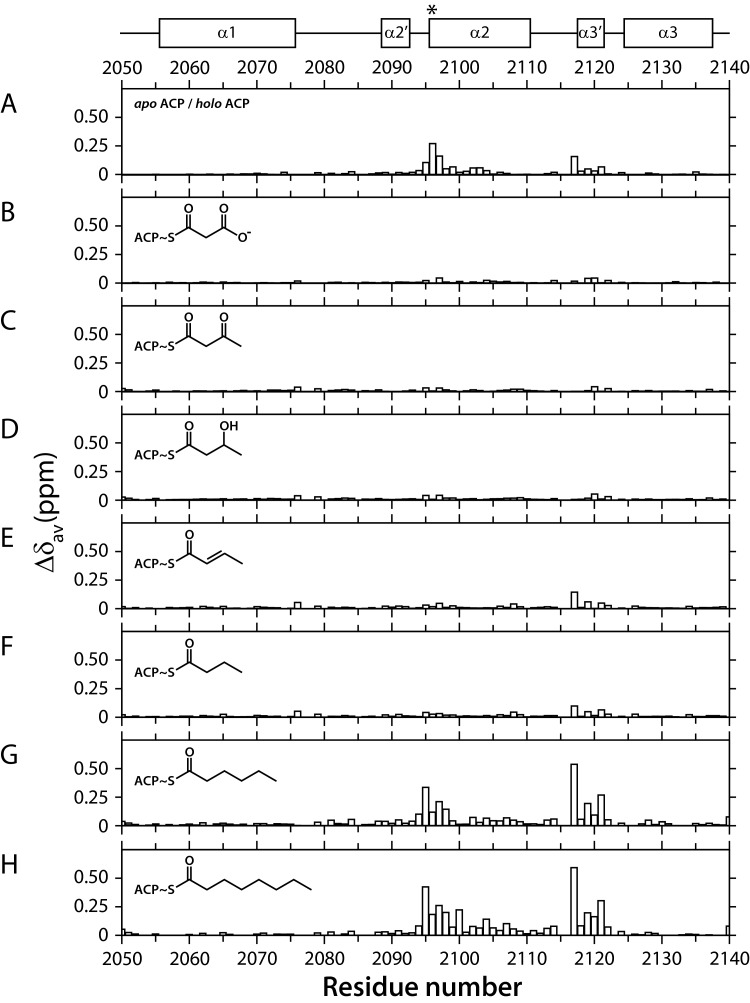
Chemical shift differences between modified forms of mACP9Underneath a schematic defining the boundaries of α-helices in the structure of apo mACP9, average chemical shift differences, Δδav, are plotted as a function of residue number. Differences are shown between holo mACP9 and the (A) apo; (B) malonyl; (C) acetoacetyl; (D) hydroxybutyryl; (E) buten-2-oyl; (F) butyryl; (G) hexanoyl; and (H) octanoyl forms. Ser2096, the point of attachment for the prosthetic group, is indicated with an asterisk.